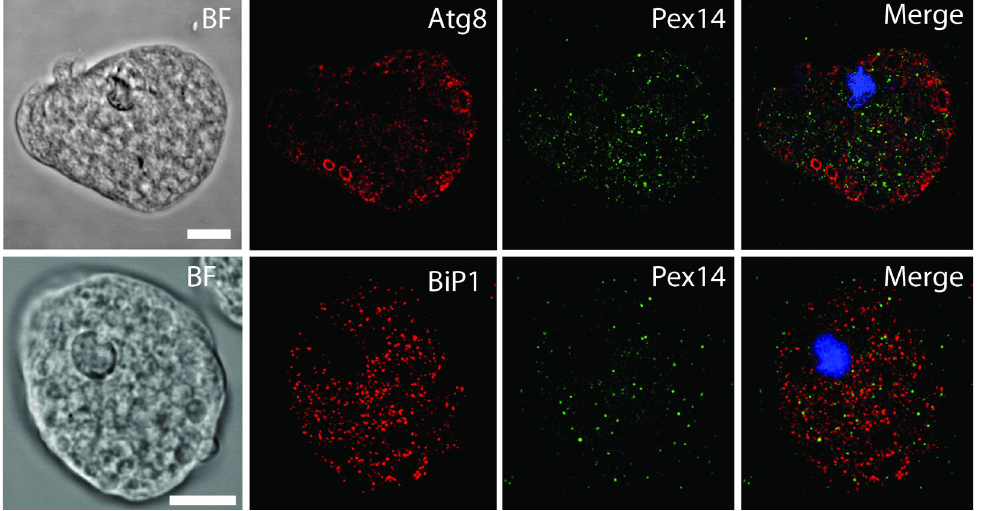
Fig 6. Confocal microscopy of vesicles labeled with Pex14, ER marker BiP1 and lysosomal marker Atg8. BF, bright field. Scale bar: 10 μ m.